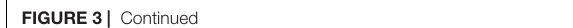
FIGURE 3 | Continued (Upper panel) Scheme showing the MarR domain of the EmrR protein (dark gray, entry IPR000835 from the InterPro database) with a predicted four-element fingerprint signature for the MarR family (light gray, entry PR00598 from the PRINTS database). Substitution of arginine for histidine at position 92 found in the mutant emrR R92H is indicated (red bar). (Bottom panel) Disk diffusion assay performed on MH plates in triplicate with the indicated strains to verify the susceptibility to nalidixic acid (NAL), ciprofloxacin (CIP), norfloxacin (NOR), and levofloxacin (LVX). (B) MIC assay on LB plate with increasing concentrations of nalidixic acid in emrR mutant strains. (1) C. violaceum ATCC 12472; (2) (cid:49) emrR ; (3) emrR R92H ; (4) WT(pMR20); (5) (cid:49) emrR (pMR emrR ); (6) (cid:49) emrR (pMR20). (C) Point mutation in gyrA conferred resistance to multiple quinolones. (Upper panel) Schema locating the mutation in threonine 85 (red bar) of the spontaneous mutant gyrA T85I within the QRDR region (amino acids 67–106) of GyrA. Domains of GyrA are indicated (DNA topoisomerase N and C-terminal domains indicated in dark and light gray). (Bottom panel) Disk diffusion assay for gyrA T85I mutant with NAL, CIP, NOR, and LVX as stated in A. EmrR and GyrA proteins in the scheme are not in